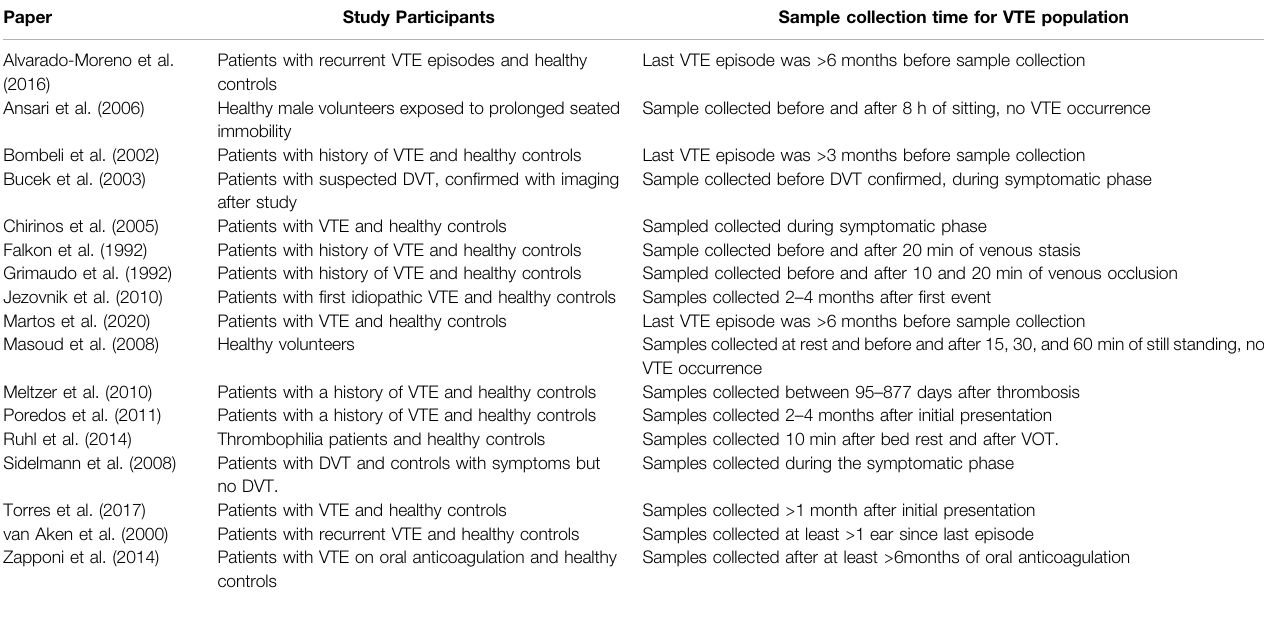
TABLE 2 | Sample collection time relative to VTE event in selected